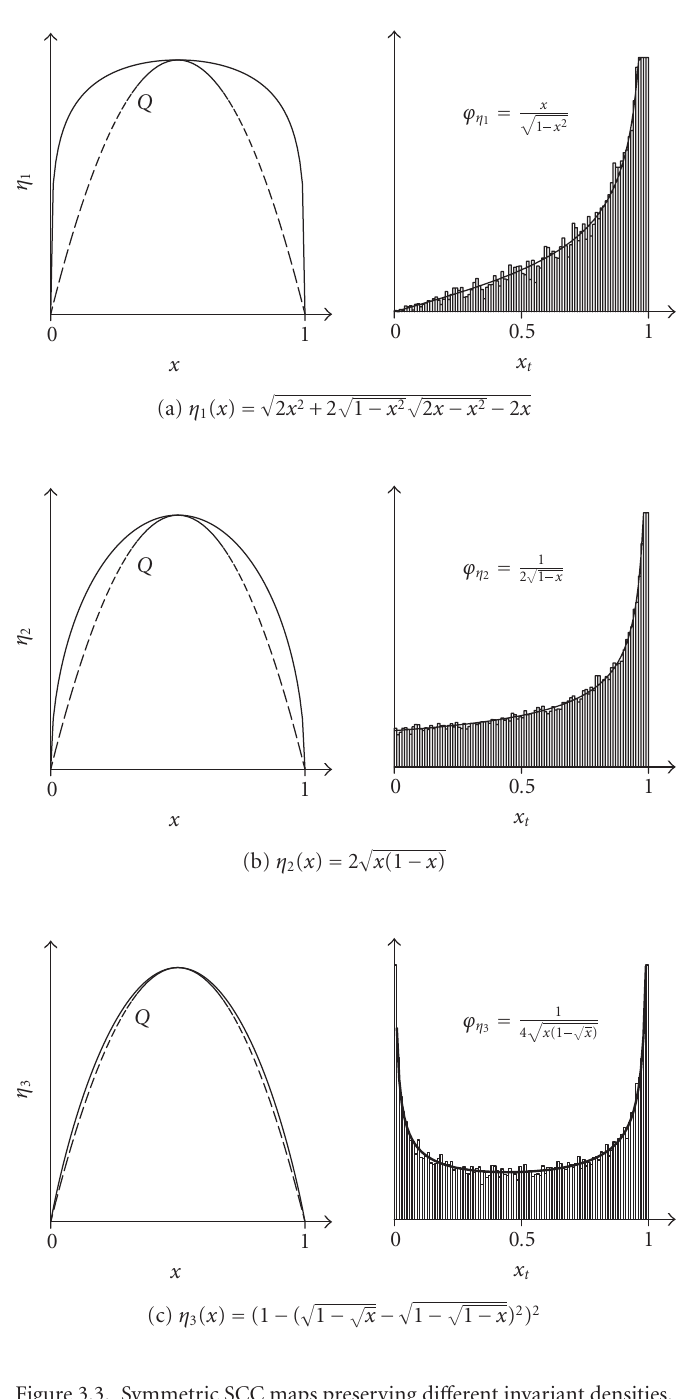
Figure 3.3. Symmetric SCC maps preserving di ff erent invariant